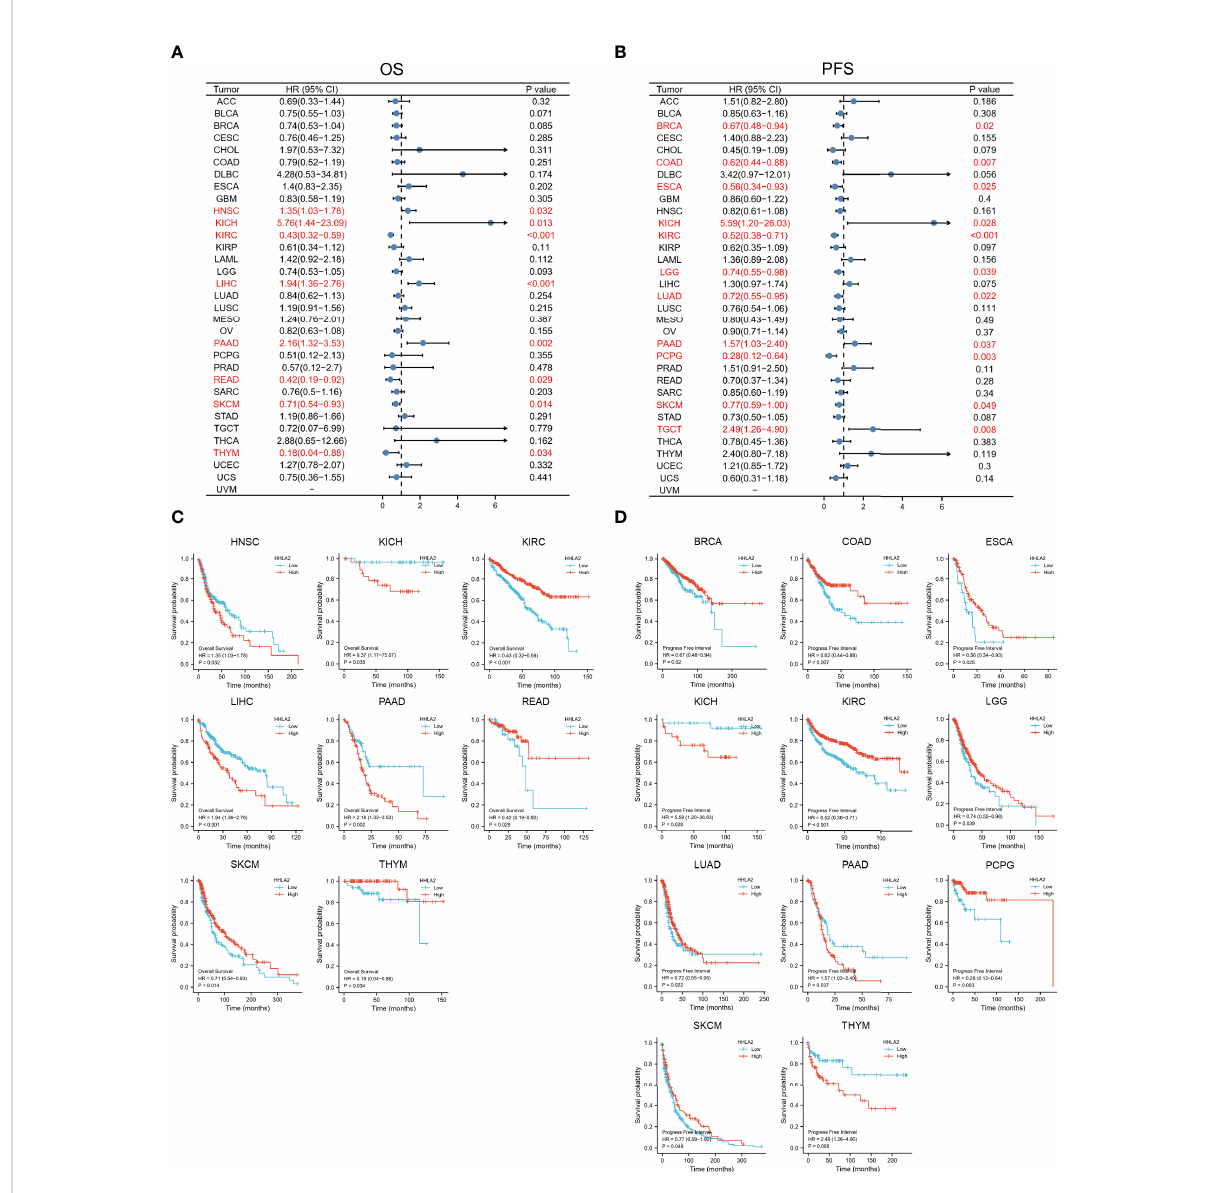
FIGURE 2 The relationship between HHLA2 expression and survival time of 33 kind of tumors was analyzed by univariate survival analysis. (A) Forest plot exhibited the relationship between HHLA2 expression and OS; (B) The relationship between HHLA2 expression and PFS; (C) KM curves of high and low HHLA2 expression in 8 tumors demonstrated the signi fi cant association between HHLA2 expression level and OS survival; (D) KM curves of high and low HHLA2 expression in 11 tumors indicated that HHLA2 was signi fi cantly associated with